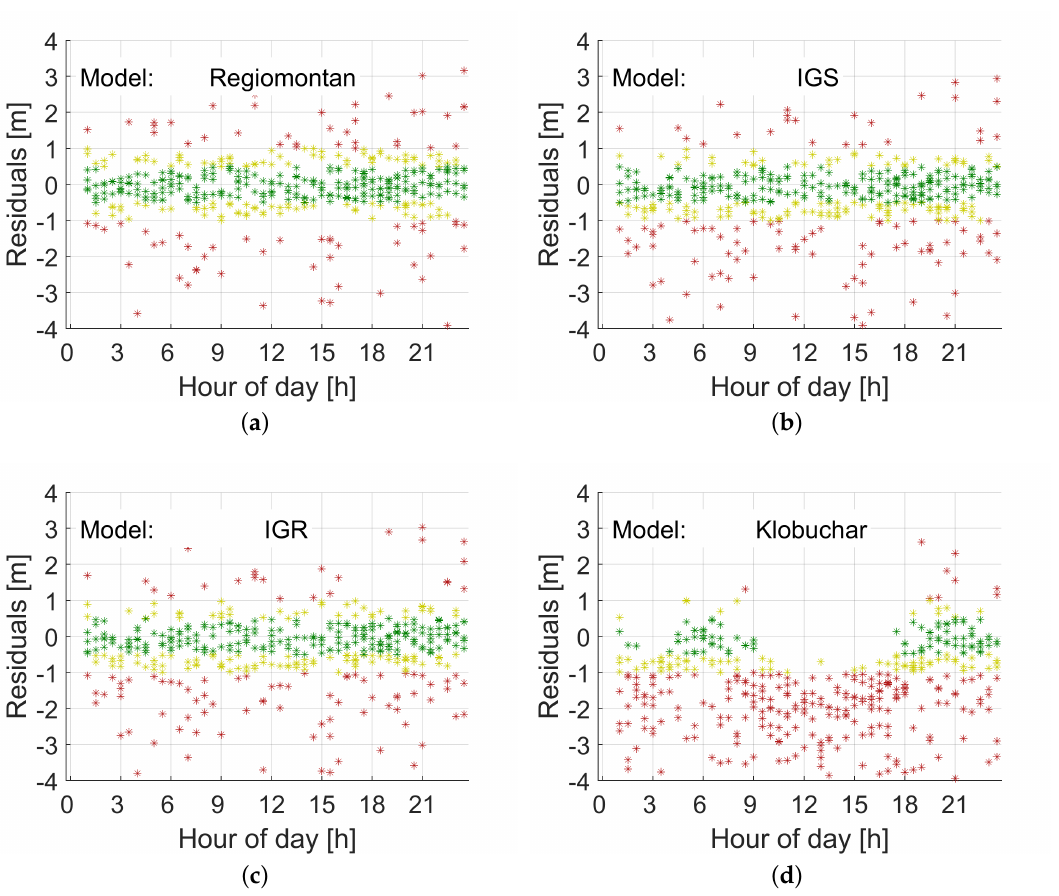
Figure 4. Range residuals for station WOFU on doy 153, 2019. Green indicates residuals smaller than 0.5m, yellow residuals smaller than 1m, and red residuals larger than 1m: ( a ) Regiomontan; ( b ) IGS final TEC grid (IGS); ( c ) IGS rapid TEC grid (IGR); and ( d ) Klobuchar. The Klobuchar model overestimates the ionospheric delay during the daytime. The other models yield very similar results. All observations down to an elevation angle of 5°are included. Table 2. Statistics of the range residuals ( P 1 + dIon ) − P 3 for all 22 stations of the Regiomontan station network. All observations down to an elevation angle of 5° are included. The results are listed for